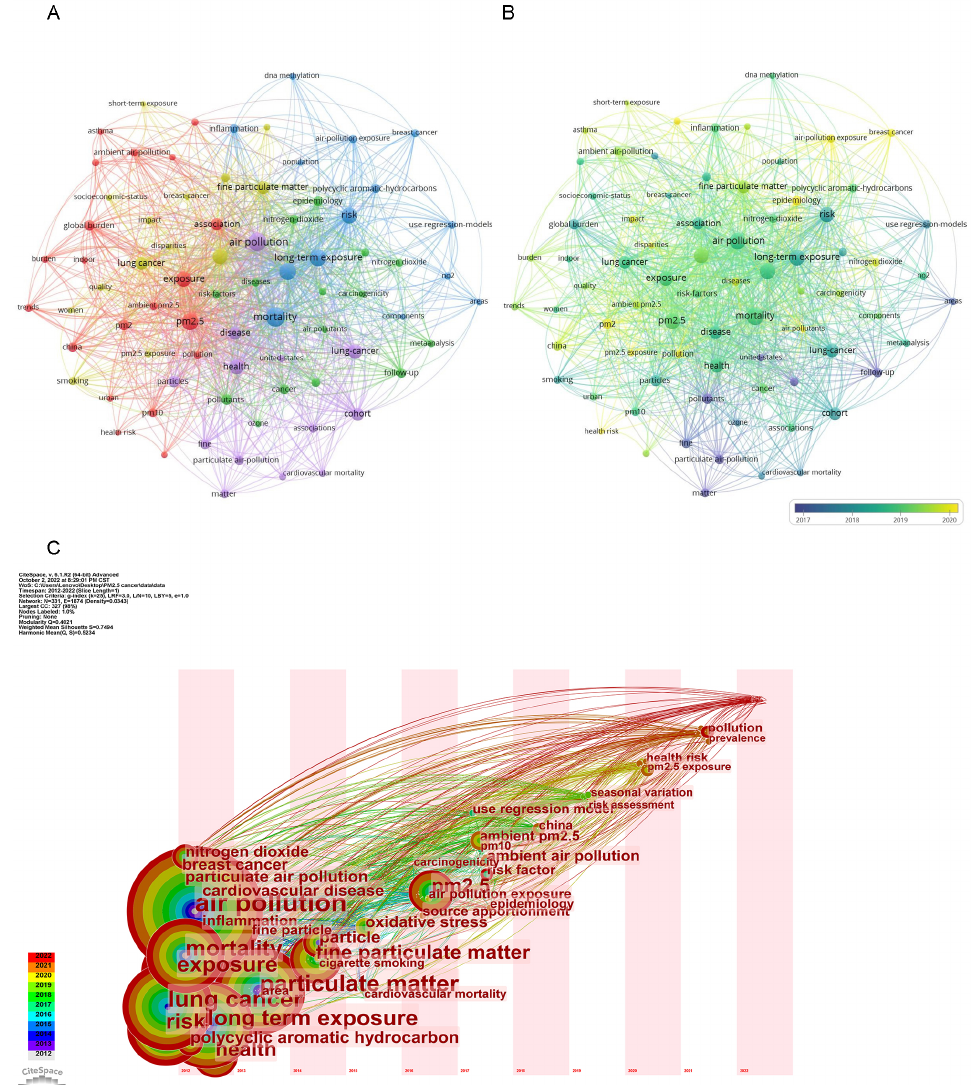
Figure 5. Figure 5. Co-occurrence analysis of keywords. ( A ) Network visualization of keywords of studies. ( B ) Distribution of keywords according to average publication year (blue: earlier, yellow: later). ( C ) The visualization of timezone of keywords from 2012 to 2022. We can see the publication time at the bottom of the figure, the line between each keyword represented their